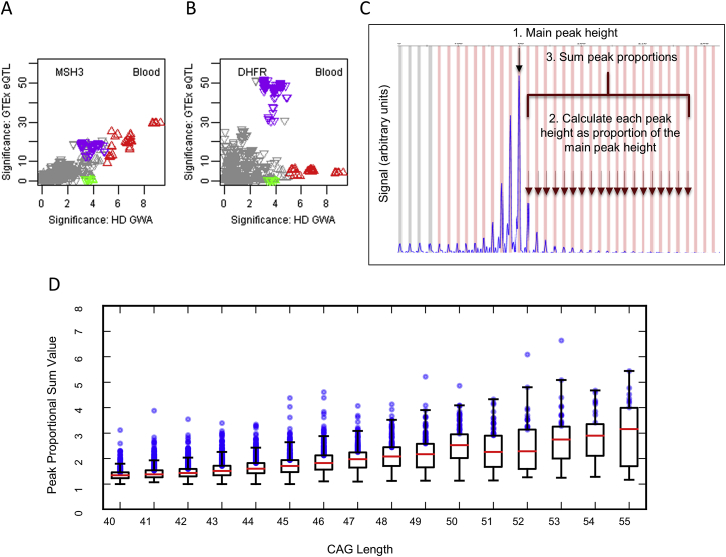
Onset-Hastening Modifier 5AM1 Is Associated with Somatic CAG Repeat Expansion, Related to Figure 3(A and B): HD modifier GWAS signals in the MSH3/DHFR region of chr 5 region (x axis, -log10(p value)) were compared to GTEx eQTL signals for MSH3 and DHFR in whole blood (A) and (B), respectively). Upward and downward triangles represent SNPs whose minor alleles were associated with increased and decreased expression levels of the test gene, respectively. Red, green, and purple triangles represent SNPs tagging modifier haplotypes 5AM1, 5AM2, and 5AM3, respectively, as in Figure 3.(C) Method for calculating the peak proportional sum of HTT CAG expansion values from ABI GeneMapper fragment sizing profiles of expanded alleles from our CAG genotyping assay. The bulk of the PCR product for any individual corresponds to the presumptive inherited expanded CAG size and constitutes a floor with respect to which expansion can be examined. PCR products to the left of the main peak are believed to be due largely to PCR artifacts. The peaks to the right of the main peak result from somatic CAG expansions. These are summed and then divided by the size of the main peak to calculate the peak proportional sum of expanded alleles in that individual. The method detects those mosaic individuals with the highest proportion of somatically expanded alleles but is not effective for resolving individuals with reduced somatic expansion. Consequently, it is only applicable to modifier SNPs minor alleles that 1) correspond to blood eQTLs or structural changes, 2) are sufficiently frequent to generate an adequate sample size and 3) are associated with increased somatic expansion (expected to correspond to hastened onset). Of the modifiers in Table 1, only 5AM1 met these criteria.(D) The boxplot shows the peak proportional sum HTT CAG repeat expansion values determined for 7,013 GWA12345 subjects, plotted as quartiles (whiskers1.5∗IQR) for each CAG repeat size. The proportion of expanded alleles per individual increases with inherited CAG repeat length. The top quartile at each repeat length, representing individuals with the highest proportion of somatic expansions, is distinguished by a wider range of values than the other three quartiles across the CAG repeat lengths. The values for the 1,753 individuals in the highest expansion quartile are plotted as blue circles. Among these individuals, 5AM1-tag SNP rs701383 deviates from Hardy-Weinberg expectation (chi-square 15.80, 2 d.f., p < 0.0004) due to an excess of the A minor allele, associated with hastened onset and increased MSH3 expression.